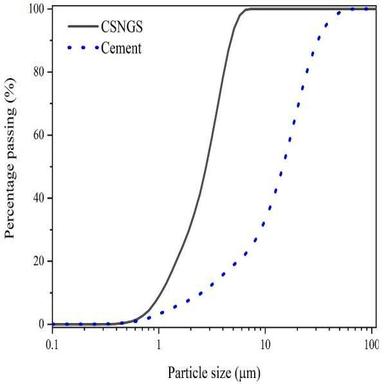
The particle size distribution curves of CSNGS and cement.